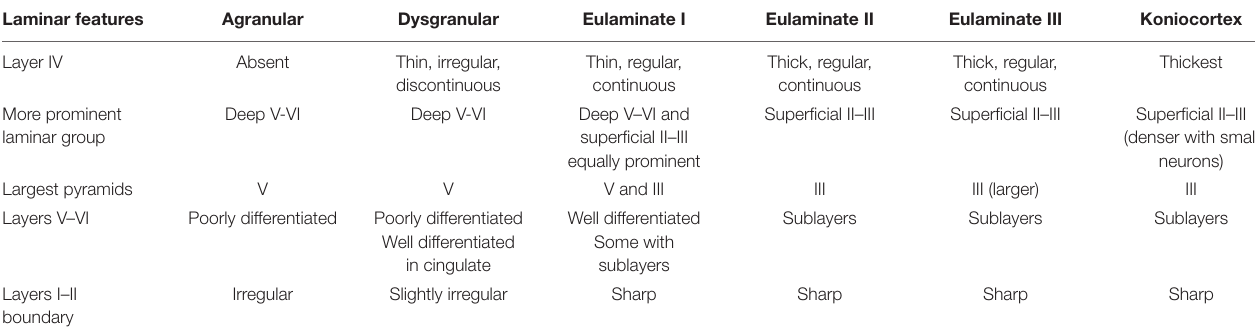
TABLE 2 | Laminar features of cortical types across human